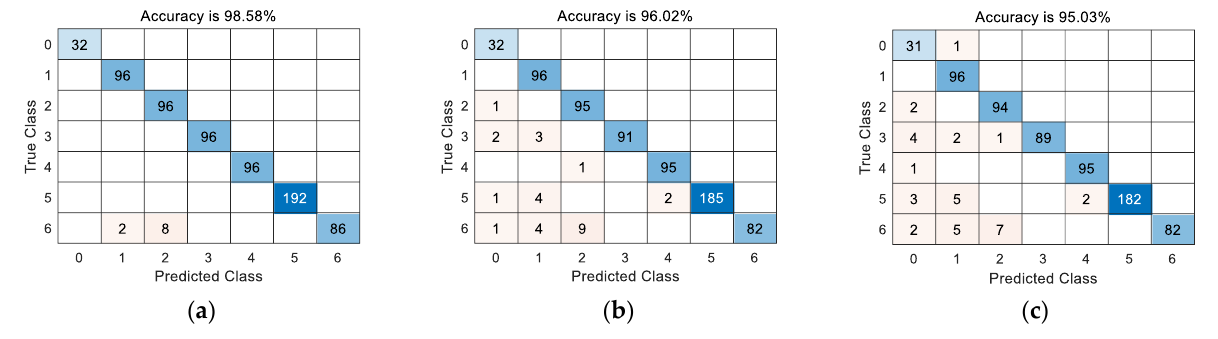
Figure 14. Confusion matrix of Res-BiLSTM fault classification results under different noises: ( a ) 25 dB ; ( b ) 20 dB; ( c ) 19 dB. ( a ) 25 dB; ( b ) 20 dB; ( c ) 19 dB.